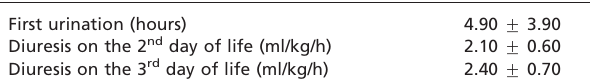
Table 3 - Evaluation of Diuresis.